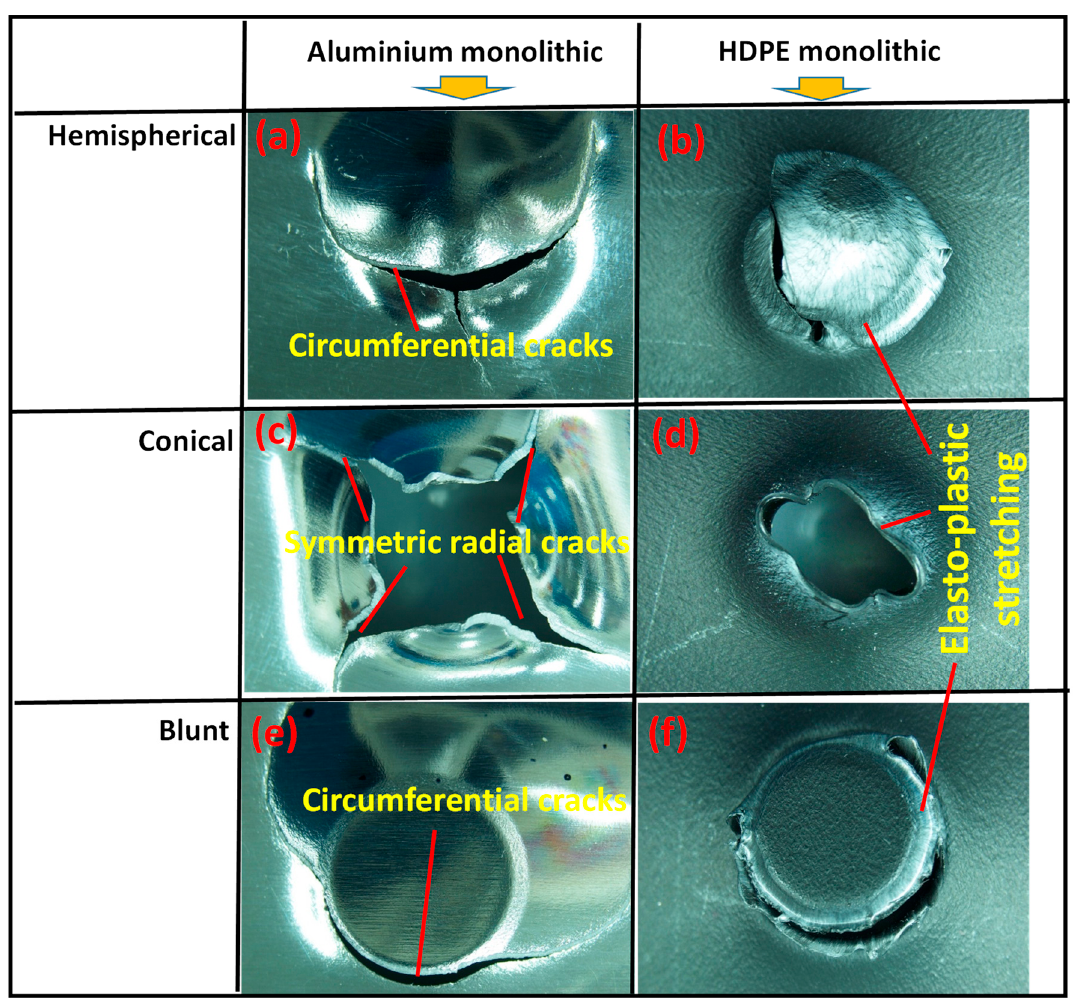
Figure 5. Failure modes of monolithic aluminium ( a , c , e ) and HDPE ( b , d , f ) perforated by different indenters. Only the back surfaces of the specimens are shown to illustrate the failure and deformation mechanisms.